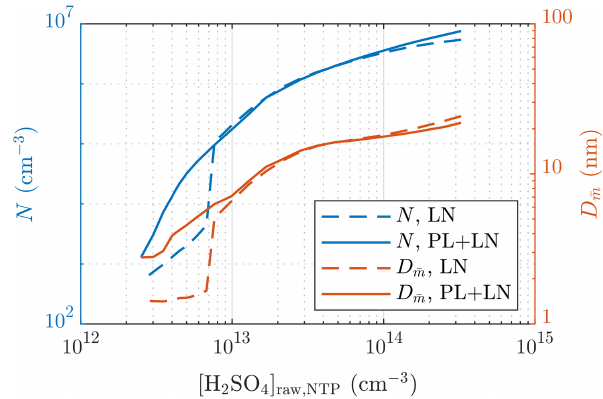
Figure 12. Comparison of the particle number concentrations and the diameters with the average mass after the ejector diluter simu- lated using the LN distribution only and using both the PL and the LN